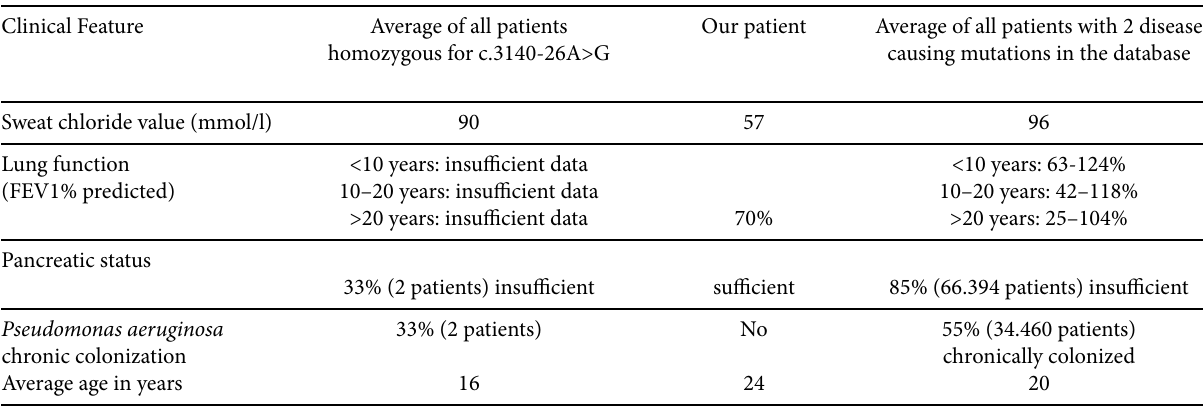
Table 3. Clinical features of the c.3140-26A>G homozygous patients as listed in the CFTR2 mutation database, compared to all listed CF patients with 2 disease causing mutations and to our patient. Clinical